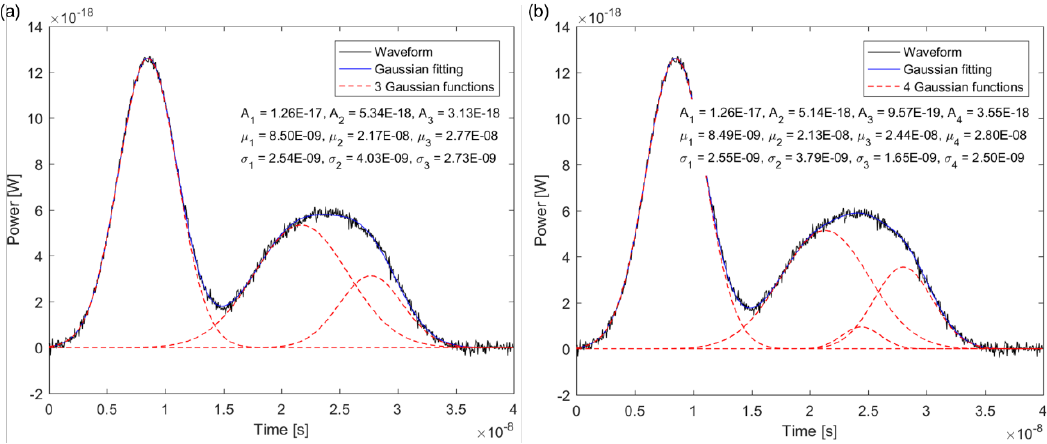
Figure 9. Gaussian decomposition results using ( a ) 3 Gaussian functions and ( b ) 4 Gaussian functions